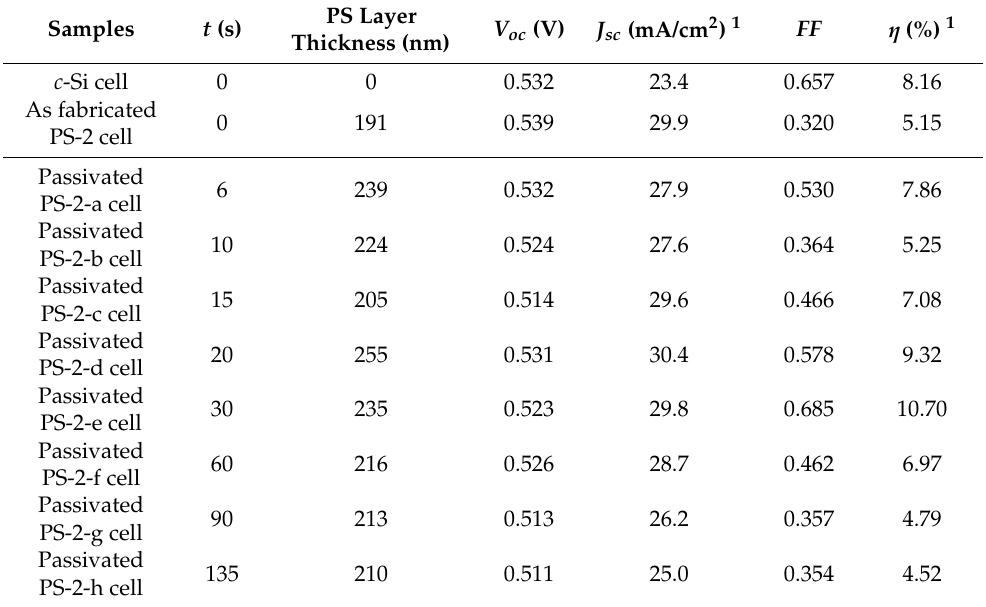
Figure 6. ( a ) J–V curves; ( b ) η ; ( c ) J sc ; ( d ) FF ; ( e ) V oc for as-fabricated PS-2 cell, passivated PS-2-(a-h) cells with different t , and reference c -Si cell. Table 3. PV parameters for as-fabricated PS-2 cell, passivated PS-2 cells with different t , and reference c -Si